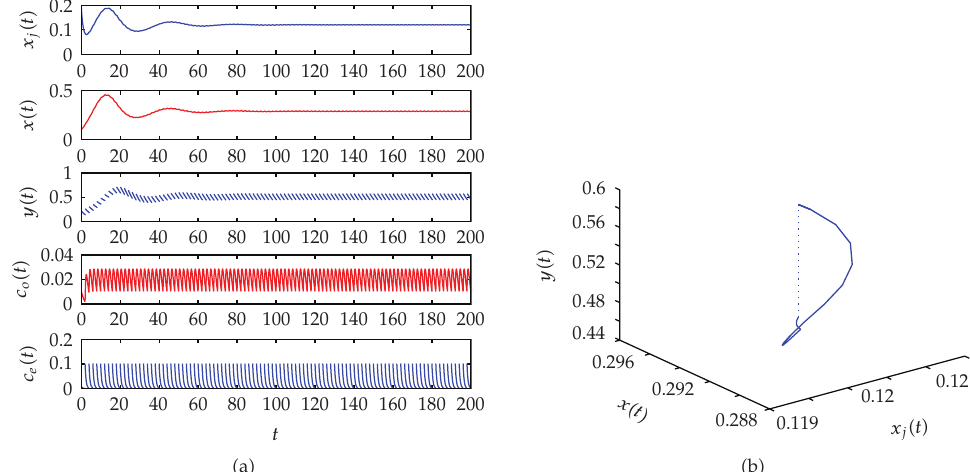
Figure 4: Dynamical behavior (cid:6) permanence (cid:7) of system (cid:6) 2.1 (cid:7) with a (cid:8) 0 . 8, b 1 (cid:8) 0 . 9, τ (cid:8) 0 . 7, f (cid:8) 0 . 2, β (cid:8) 0 . 9, η (cid:8) 1, r (cid:8) 0 . 7, b 2 (cid:8) 0 . 3, λ (cid:8) 0 . 9, k (cid:8) 1, g (cid:8) 0 . 5, m (cid:8) 0 . 7, h (cid:8) 2, l (cid:8) 0 . 1, T (cid:8) 2, and μ 2 (cid:8) 0 . 1, initial values x j (cid:6) 0 (cid:7) (cid:8) 0 . 2, x (cid:6) 0 (cid:7) (cid:8) 0 . 1, y (cid:6) 0 (cid:7) (cid:8) 0 . 1, c o (cid:6) t (cid:7) (cid:8) 0 . 01, and c e (cid:6) t (cid:7) (cid:8) 0 . 01 (cid:6) ∗ corresponding theoretical criteria value: (cid:8) 0 . 1654. (cid:6) a (cid:7) Time-series of system (cid:6) 2.1 (cid:7) with μ μ ∗∗ 1 finally tend to a T -periodic